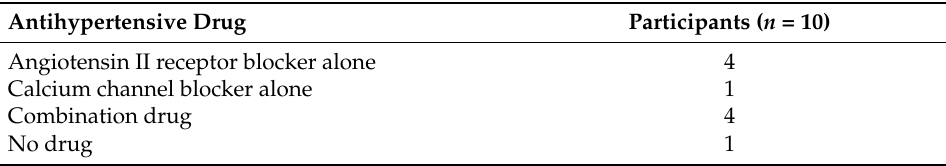
Table 3. Types of antihypertensive drugs used.